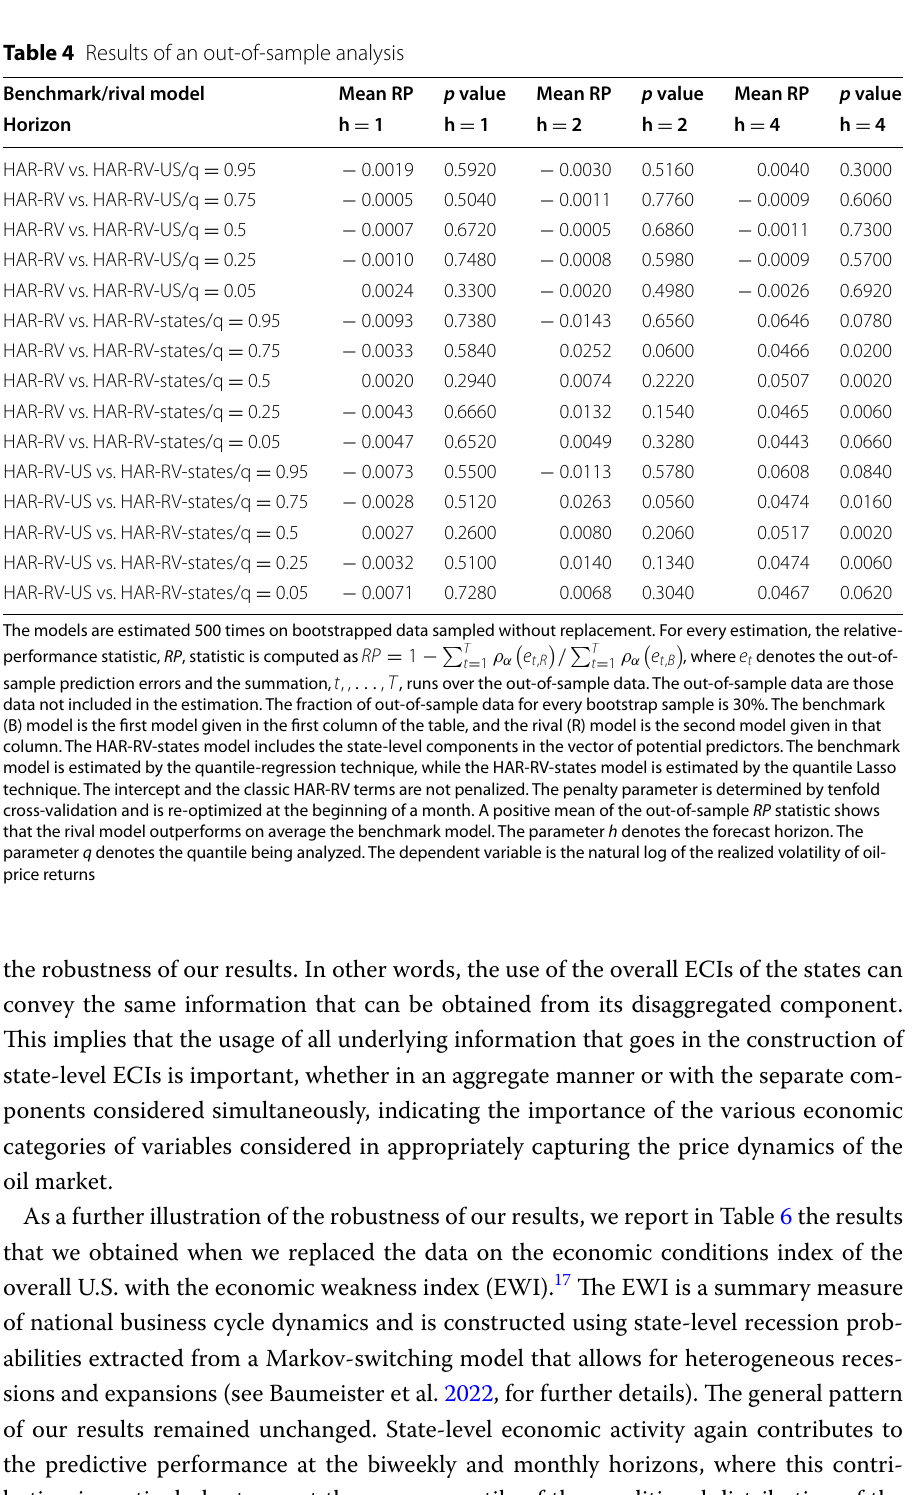
Table 4 Results of an out-of-sample analysis